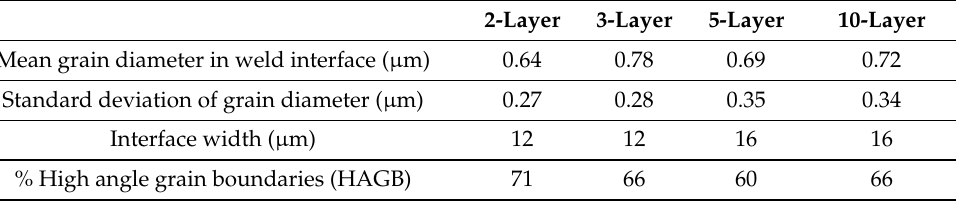
Table 1. Summary of the welding